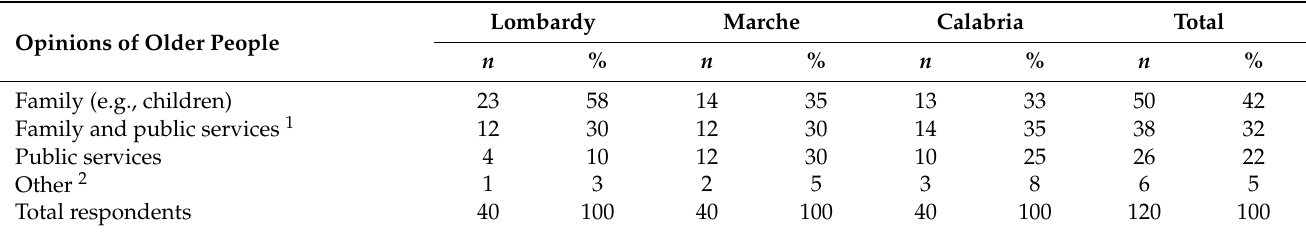
Table 4. Caring for older people: family or public responsibility? By region ( n ;